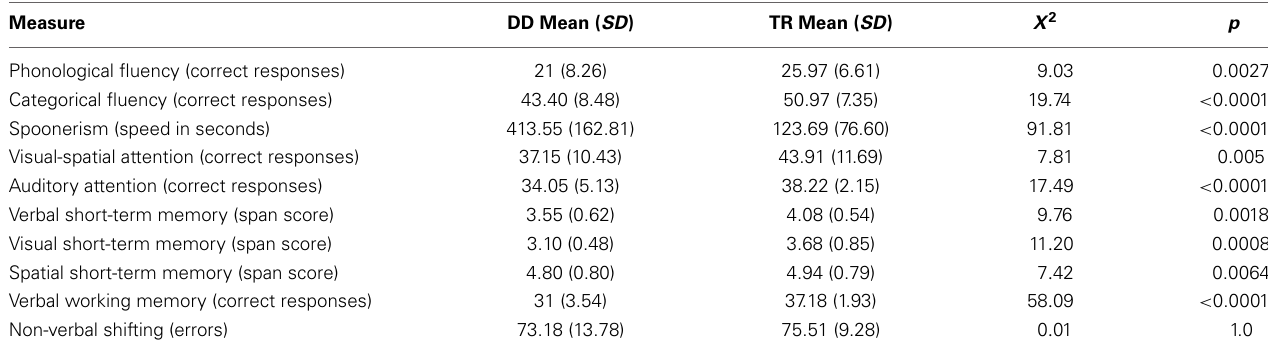
Table 1 | Performances of children with developmental dyslexia (DD) and with typical reading (TR) in executive functions tasks (after back-transformation to original measure